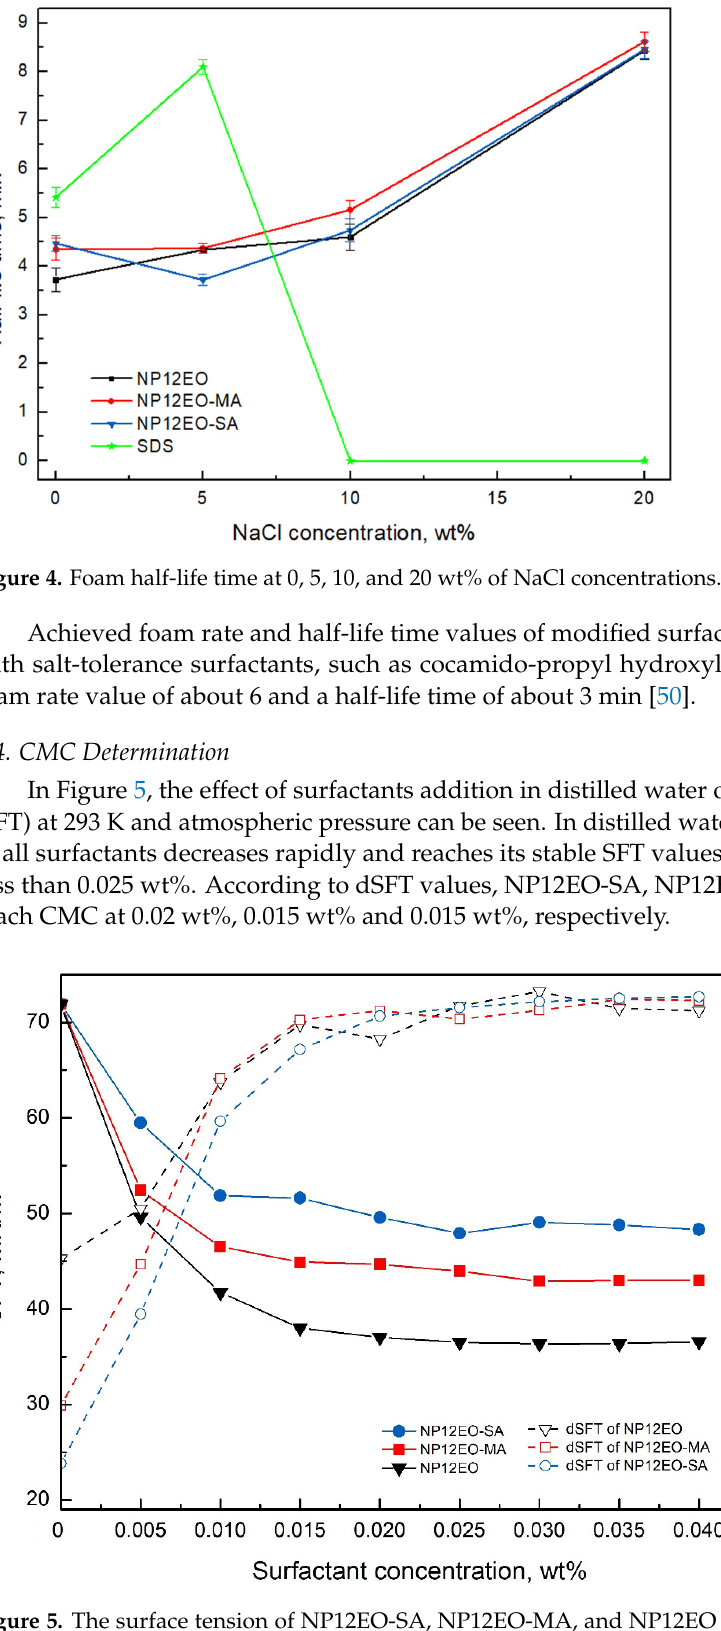
Figure 3. Foam rate of surfactants at 0, 5, 10, and 20 wt% of NaCl concentrations.